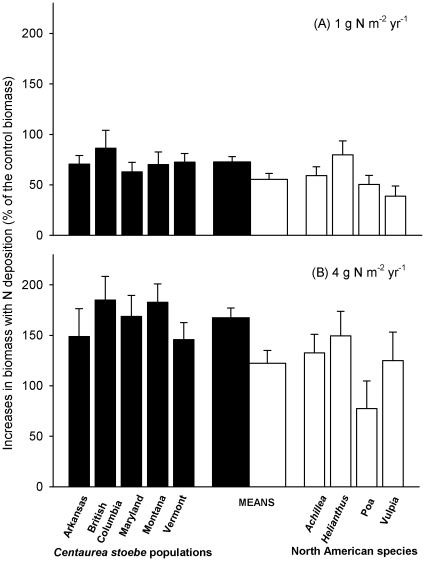
Effects of (A) low and (B) high nitrogen addition on biomass (means+1 SE) of five Centaurea stoebe populations (narrow black bars) and four North American (NA) species (narrow white bars).Wide bars are means (+1 SE) for all five C. stoebe populations (black) or all four NA species (white) combined. Increases in biomass = (Bn−Bc)/Bc×100%, where Bn was the biomass of a plant of each of the five C. stoebe populations or each of the four NA species, grown alone and subjected to low or high N deposition; Bc was the mean biomass of all the plants of each of the five C. stoebe populations or each of the four NA species, grown alone but subjected to no N addition.